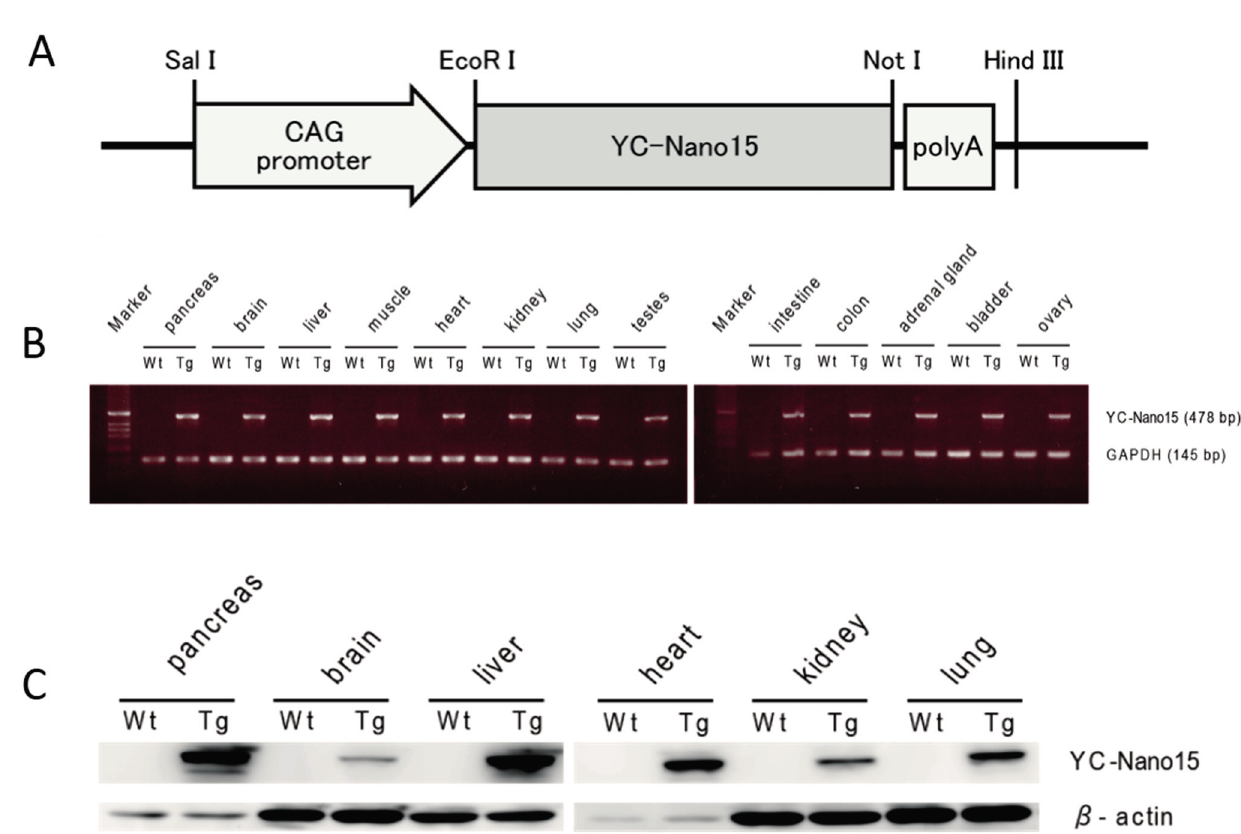
Figure 1. Yellow Cameleon-Nano 15 (YC-Nano15) is expressed ubiquitously in adult organs. ( A ) The YC-Nano15 transgene construct contains a 1.9-kb YC-Nano15 sequence downstream of the CAG promoter and upstream of the SV40 polyadenylation sequence; ( B ) Real time-PCR (RT-PCR) analysis of various tissues of YC-Nano15-205 mice revealed that mRNA of YC-Nano15 was expressed ubiquitously in the adult organs. In wild-type (C57BL/6J) mice, no band appeared in a PCR amplification using the YC-Nano15 primers (internal standard: mGAPDH ); ( C ) Western-blot analysis. YC-Nano15 protein is expressed ubiquitously in adult organs; and ( D ) Fluorescence of various organs in a YC-Nano15-205 mouse. Bright-field ( left ), CFP fluorescence ( middle ), and YFP fluorescence images ( right ) of pancreas, brain, heart, liver, and muscle of a YC-Nano15-205 (Tg) mouse and a C57BL6J (wild-type) mouse are shown. The tissues of YC-Nano15-205 mice are yellower than those of wild-type mice due to expression of